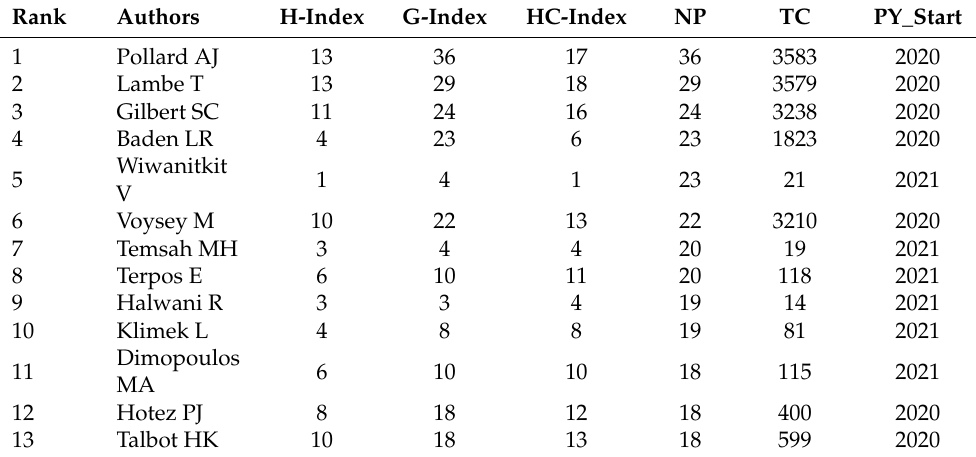
Figure 3. Authors’ collaboration network in COVID-19 vaccine research. Table 1. The most prolific authors in COVID-19 vaccine research. (NP: Number of Publications, TC: Total Citations).